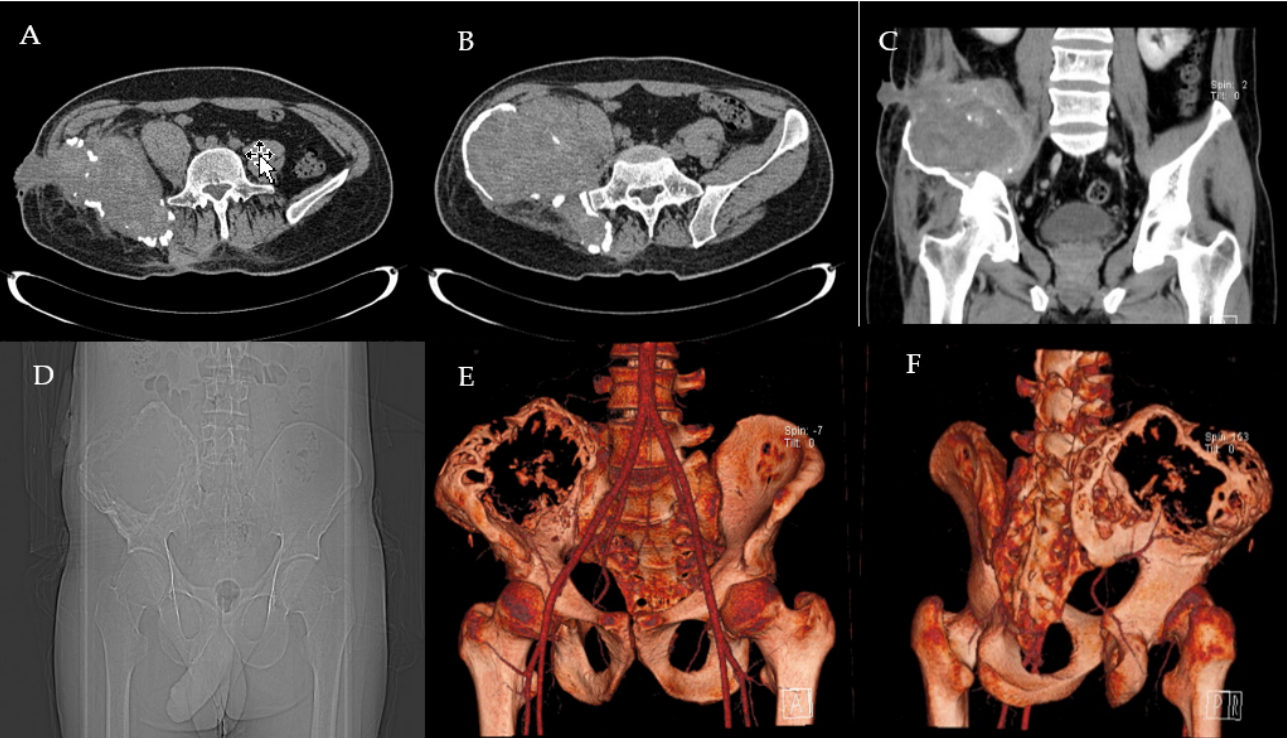
Figure 1. Preoperative CT scans ( A – C ), radiograph ( D ) and 3D reconstruction ( E , F ) of the pelvis with the right iliac pseudotumour.